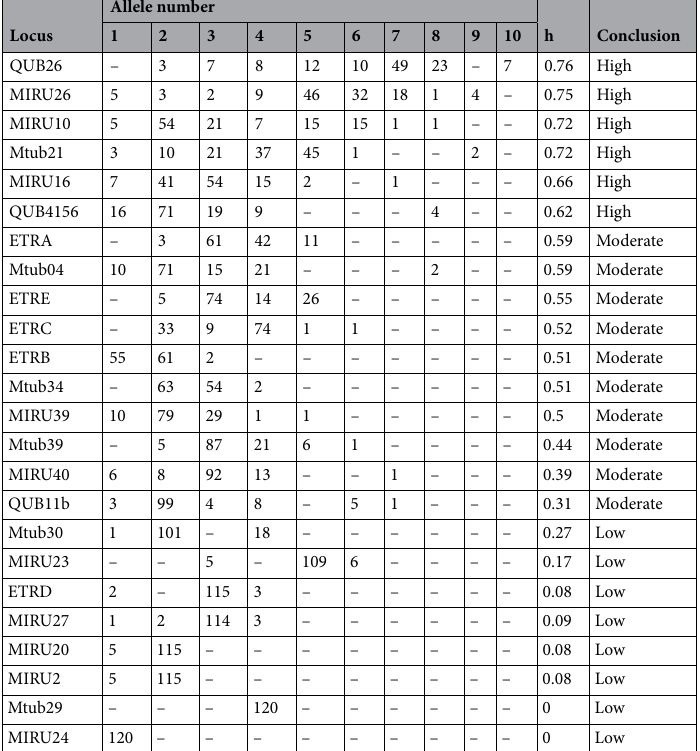
These 21 isolates exhibited 6 distinct patterns and 18 of them were divided into 3 clusters. Cluster 1 consisted of 10 isolates, 3 of which originated from a cattle farm in Mashhad and the rest (7) from a farm located in another region of the city. Cluster 2 included 6 isolates, all collected from a single farm in Mashhad. Lastly, Cluster 3 had 2 isolates, collected from a farm in Chenaran (Fig. 3). Drawing MST was based on SLV suggesting that twenty-one isolates belonged to two clonal complexes: CC1 had 17 isolates and CC2 had 4 isolates (Fig. 4). Allelic diversity, discriminatory power and recent transmission. The high genotyping discrimi- nation index for MIRU-VNTR typing was 0.71, and the rate of clustering was 85.7%. The rate of bTB recent transmission was estimated to be 71.4% in the livestock population of Khorasan Razavi. The allelic diversity of all MIRU-VNTR loci was estimated among the investigated loci, 2 loci showed moderate allelic diversity, while the diversity of the other loci was low. The locus ETRC had the highest allele diversity (h = 0.45). The table shows the number of alleles and estimated allele diversity (Table 2).